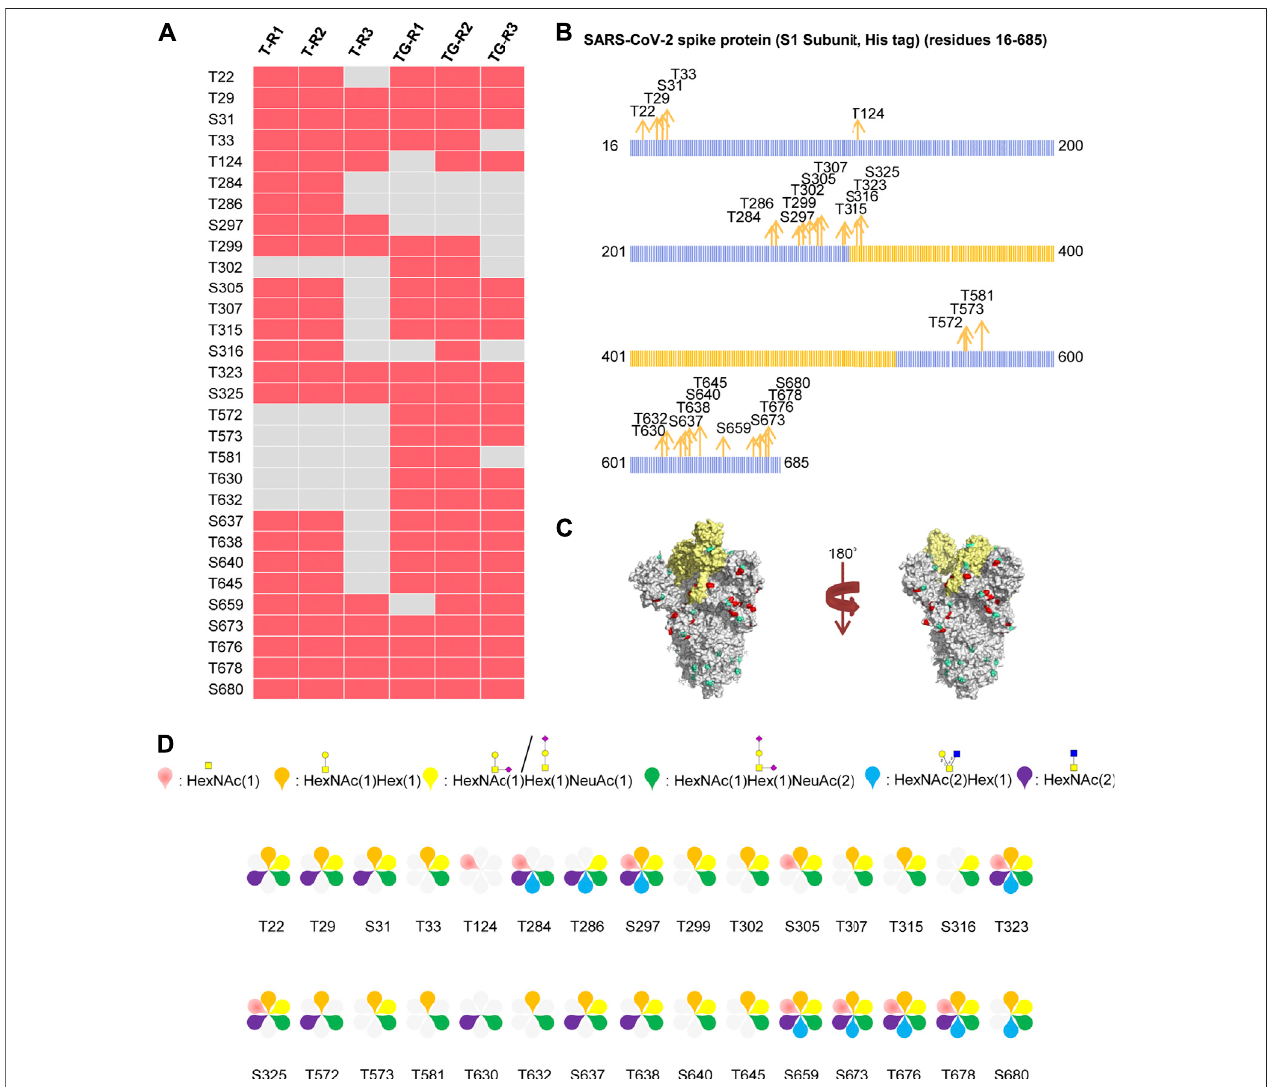
FIGURE3| Comprehensive O -glycosylationcharacterizationofSARS-CoV-2Sprotein(S1,Histag)expressedinhumancells. (A) Uncertain O -glycositesidenti fi ed using trypsin (T) or typsin/Glu-C (TG) in three replicates. (B) Mapping of identi fi ed O -glycosites to amino acid sequences. RBD is highlighted in yellow. (C) O -glycosites (red)and N -glycosites(blue)inthree-dimensionalstructureofSARS-CoV-2Sproteintrimers(PDBcode:6VSB).RBDishighlightedinyellow. (D) O -glycancompositions on each site.